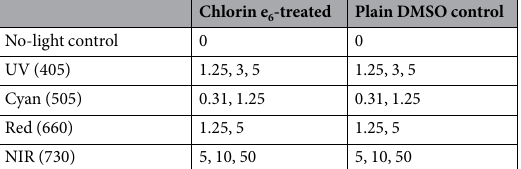
Table 1. Experimental classes for wild-type animals. Nominal radiant powers (mW) tested for each light condition ( λ , nm) for chlorin e 6 -treated or control (exposed to plain dimethyl sulfoxide, DMSO) specimens. n = 5, 15 animals per experiment, 75 animals per